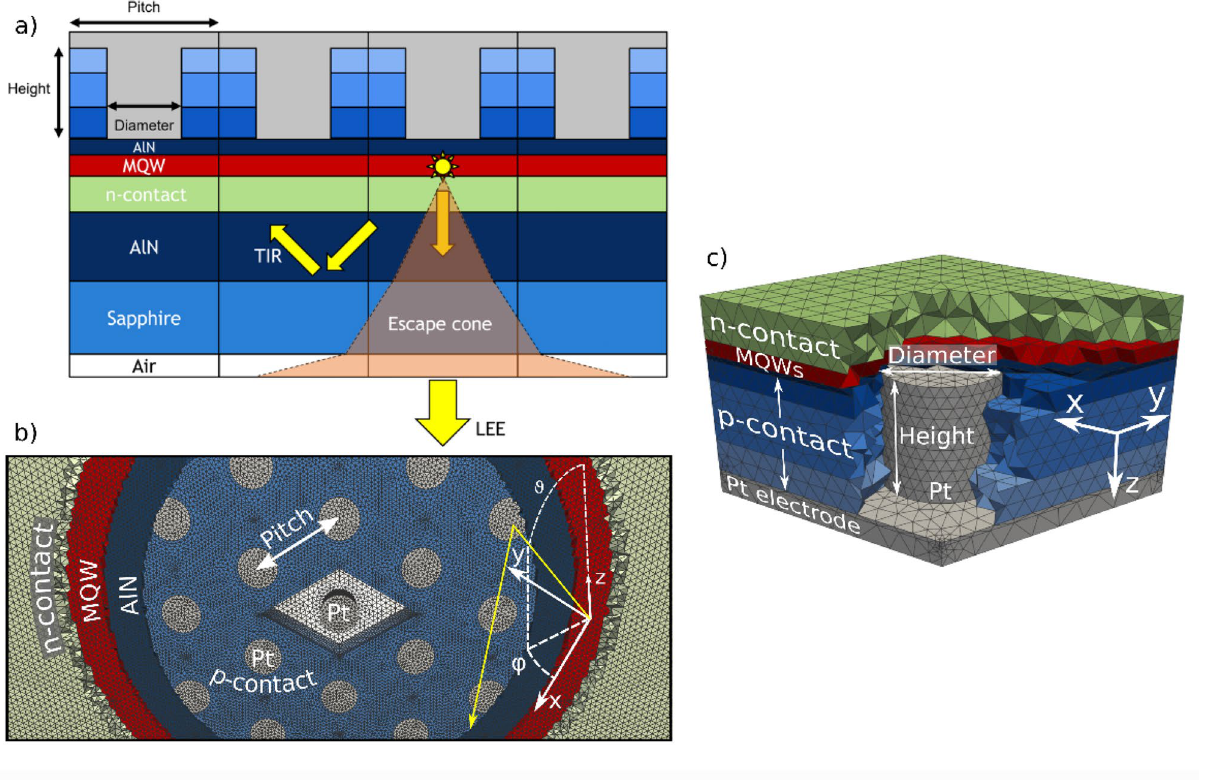
Figure 1. ( a ) Cross-section schematic of the nanostructured device showing the escape cone and total internal reflection (TIR). ( b ) The nanostructured device showing the central unit cell of the periodic lattice (diamond shape) with the p-contact, which completely fills the space between nanocylinders, hidden for visibility. The AlN, multiple quantum wells (MQW) and n-contact layers have also been partially obscured for visibility. ( c ) The periodic unit cell of the nanocylinder with layers partially hidden for